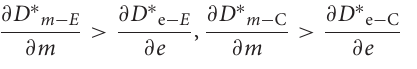
Bosch, Siemens and many others have launched customized services for home appliance products to meet the customized needs of their consumers. With the gradual development of the customization market, the original standardized home appliance market is bound to shrink resulting in the overall decline of the standardized market